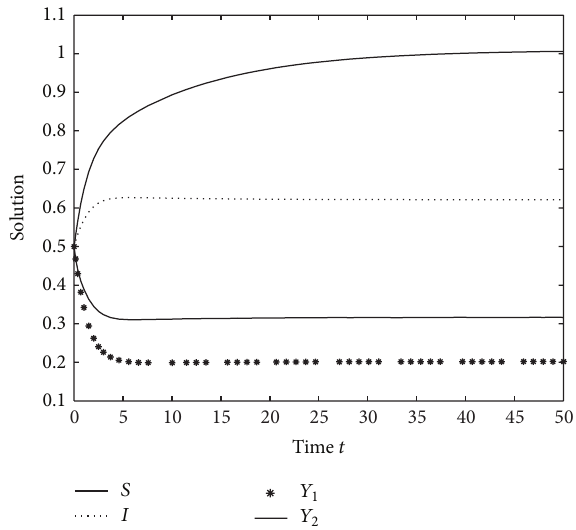
Figure 1: The temporal solution found by numerical integration of system (2) with 𝜏 = 1